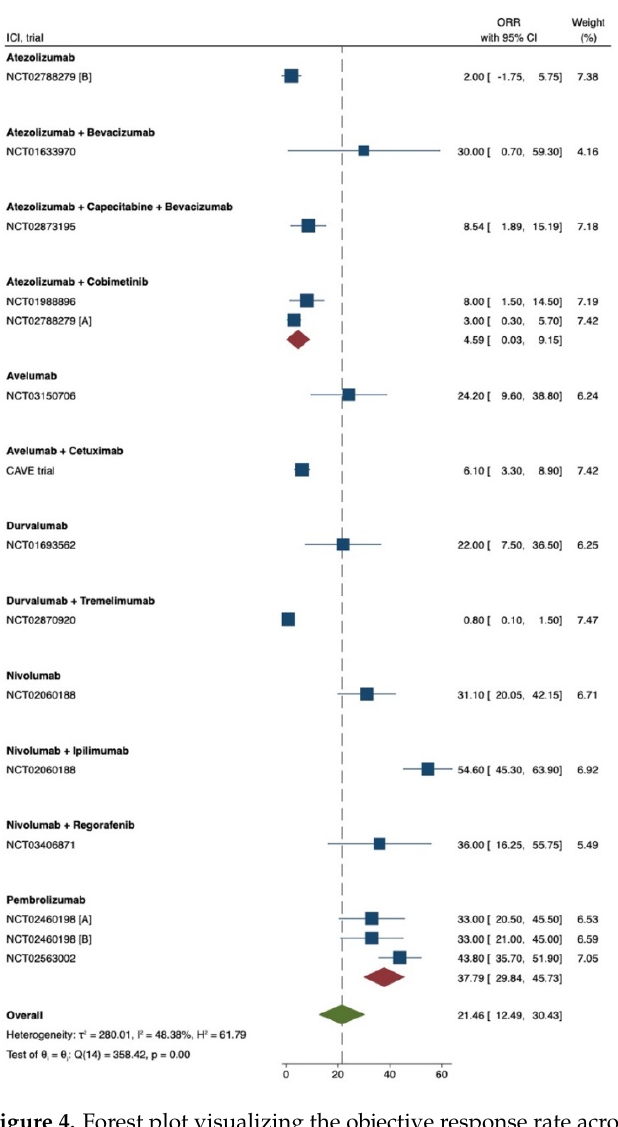
Figure 4. Forest plot visualizing the objective response rate across selected studies. The cumulative response rate is estimated to be 21.46% with non-significant differences in weight distribution across selected studies and study heterogeneity of 48.38% (deemed as moderate).